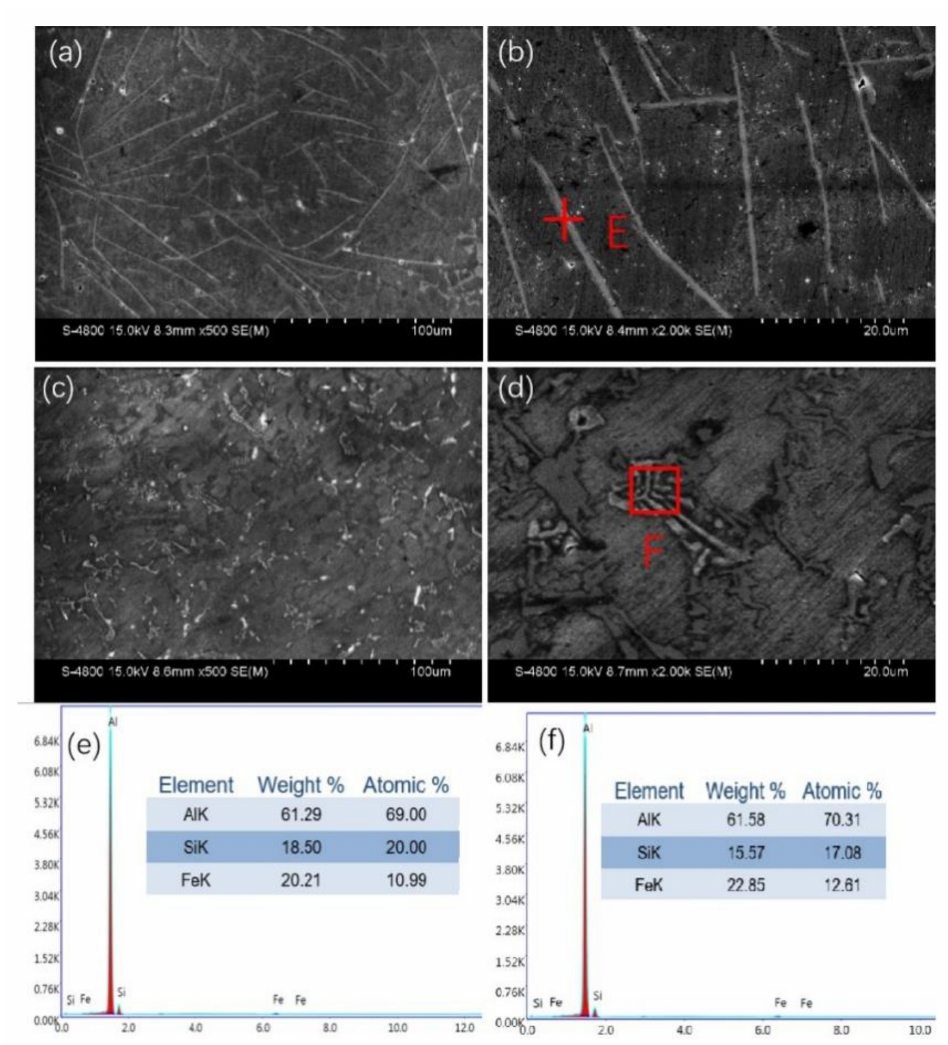
Figure 3. SEM images of the ( a , b ) C1 alloy and ( c , d ) C2 alloy. ( e , f ) are the EDS results of the ( b , d ) corresponding